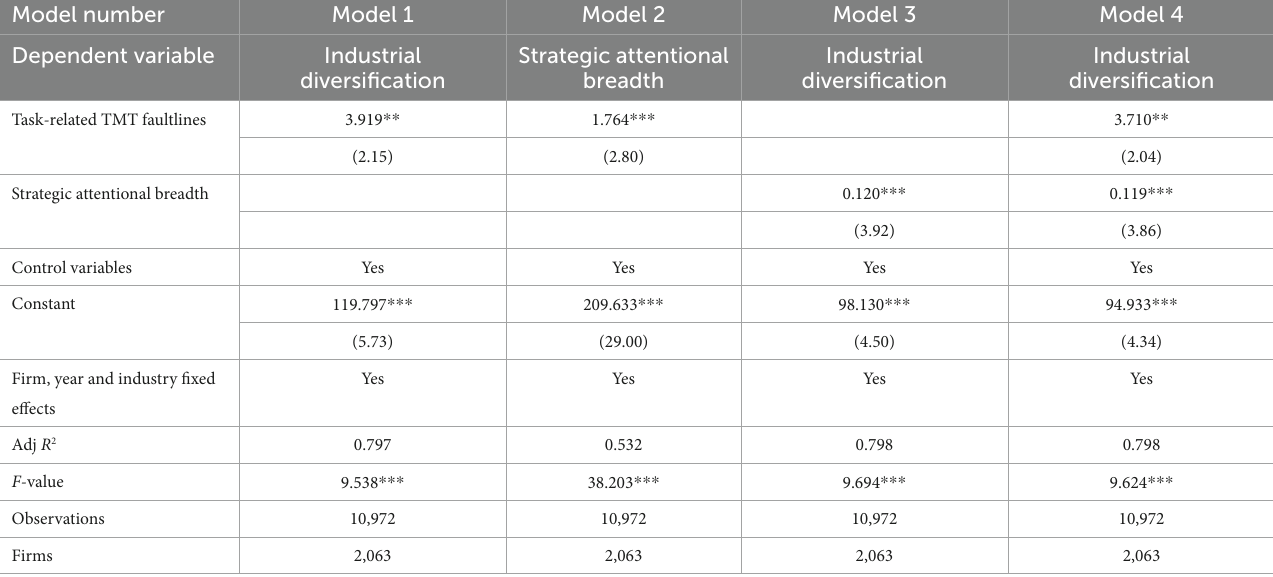
TABLE 4 Panel fixed-effects regression of the relationship between task-related TMT faultlines and corporate industrial diversification (measuring industrial diversification and strategic attentional breadth using the Entropy Measure). Model